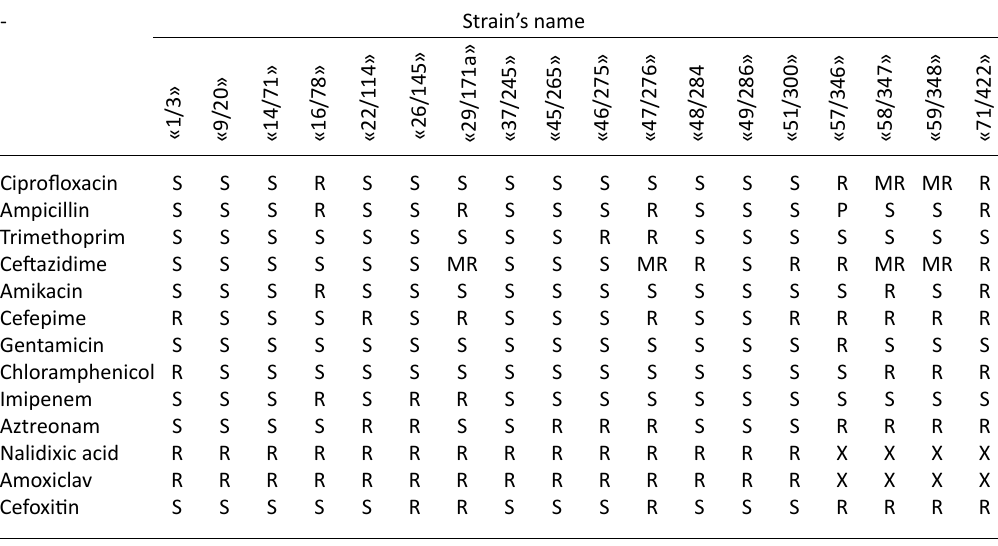
Table 3. Antibiotic profile of ceftazidime- resistant field isolates of S. enteritidis -